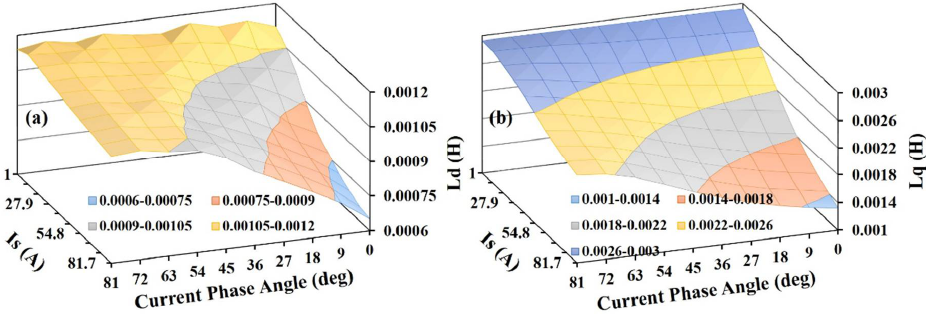
Figure 6. d-q- axis inductance of V-shaped PM IPMSM: ( a ) L d , ( b ) L q .